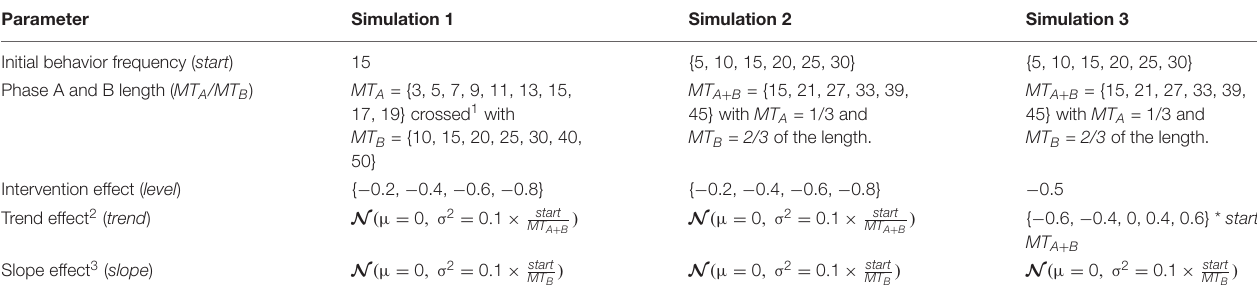
TABLE 1 | Overview of the parameter settings and iterations (runs) for the three